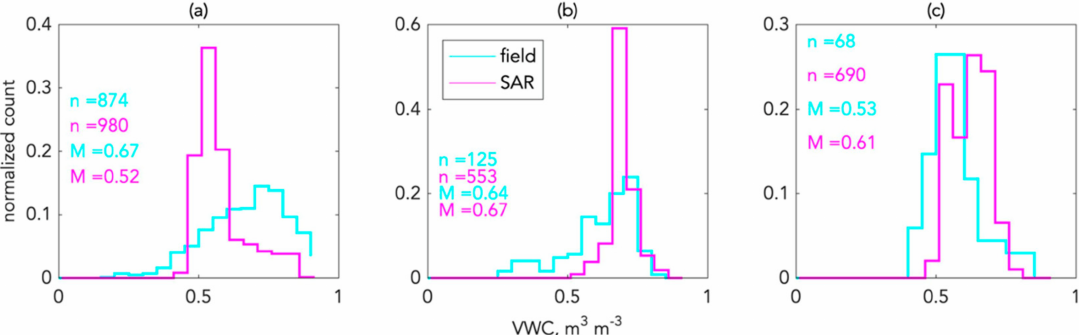
Figure 8. Frequency distributions of VWC for the ( a ) BRW, ( b ) TOO, and ( c ) YKD swaths. Population counts, n , indicate the total number of individual depth-integrated VWC observations and the number of pixels for the field and SAR datasets respectively. M indicates